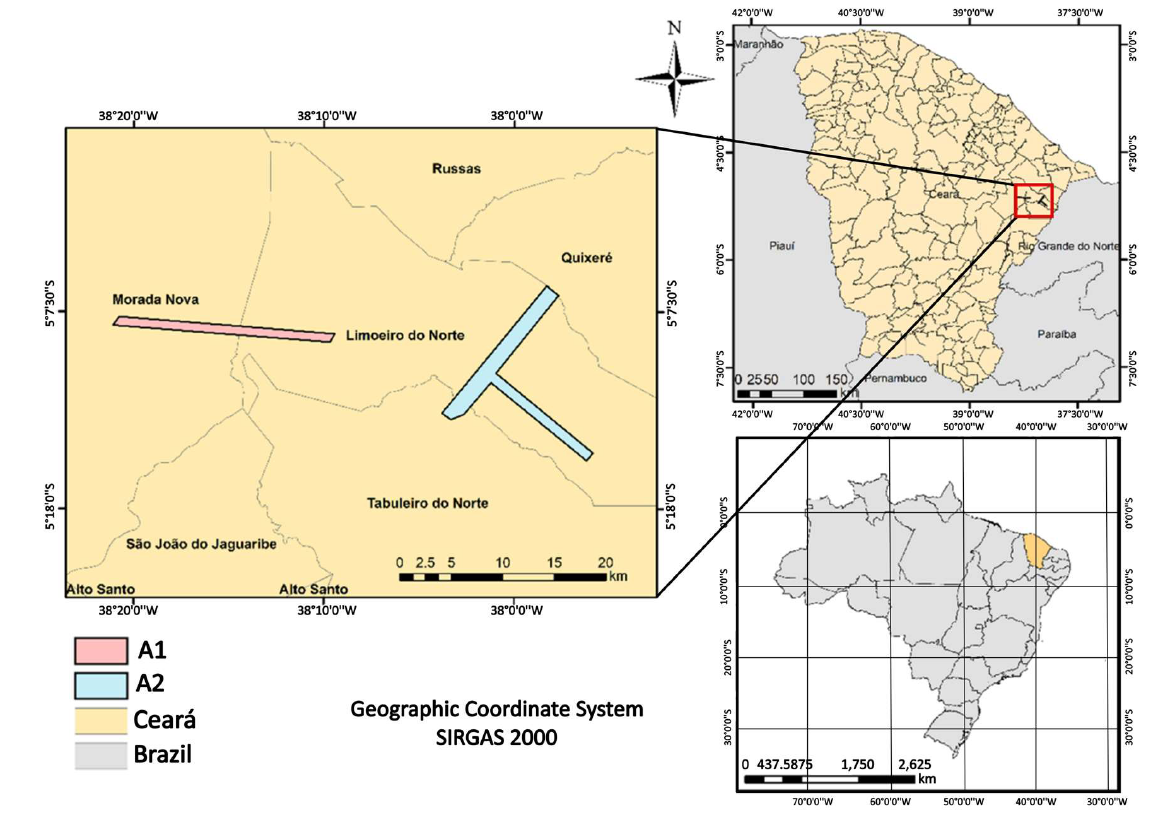
Figure 1. Map of the study